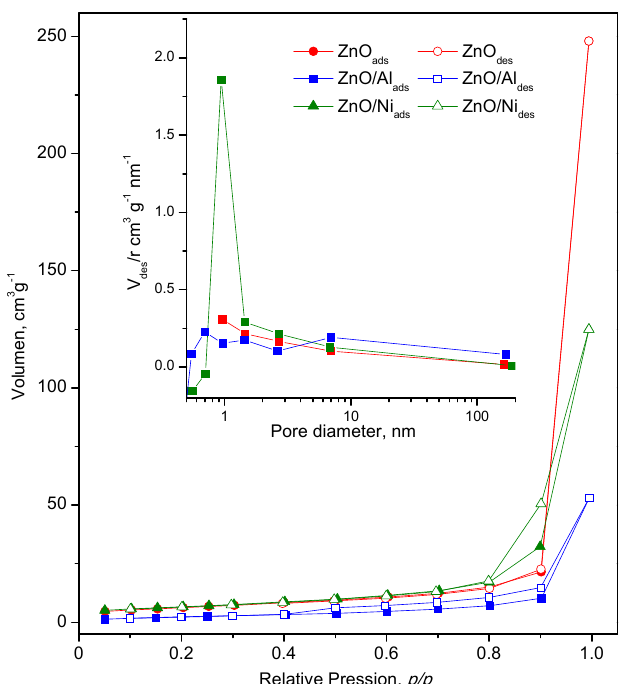
Figure 6. Nitrogen adsorption–desorption isotherms and pore size distribution curves (inset) of ZnO, ZnO–Al, and ZnO–Ni (filled symbols indicate adsorption, and open symbols indicate desorption).